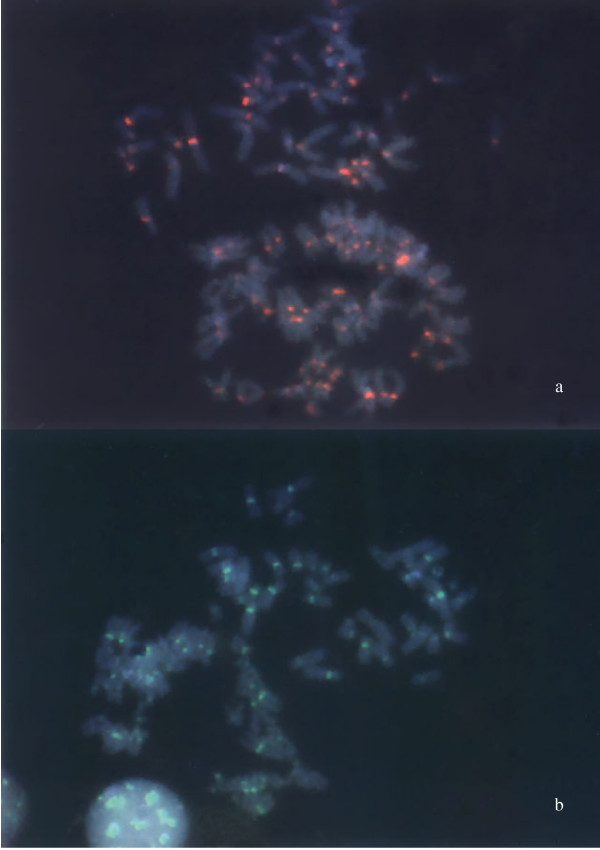
FISH PCD images. FISH PCD images. All centromeres FISH probe red signals (a), and CENP-B box FISH green signals (b) are shown.